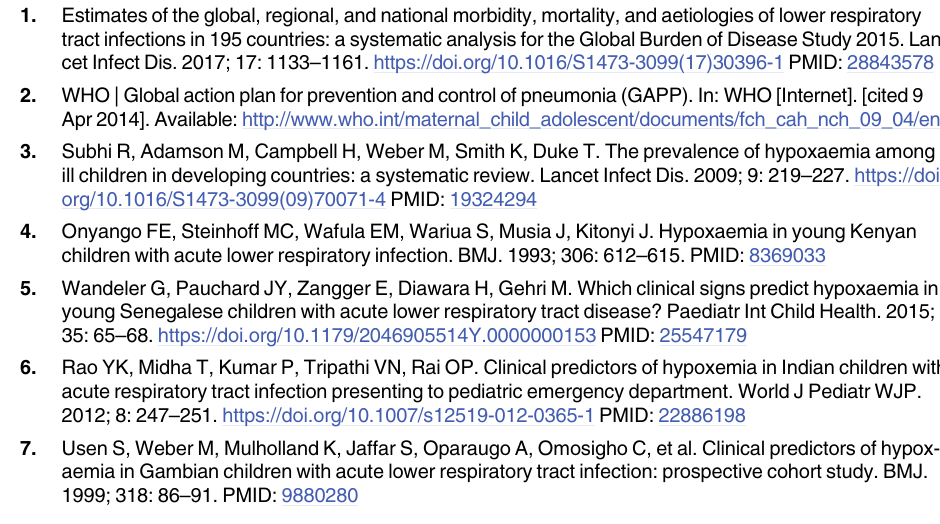
S3 Table. Hospitalization among all illness episodes. Se: sensitivity, Sp: specificity, PPV: pos- itive predictive value, NPV: negative predictive value, LR +: positive likelihood ratio, LR-: neg- ative likelihood ratio, OR: odd